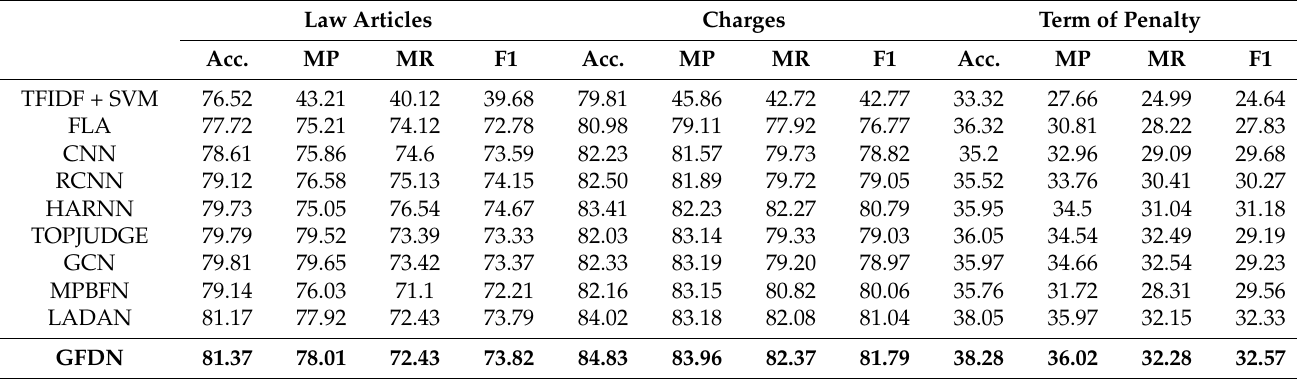
Table 5. LJP results on dataset CAIL-small.